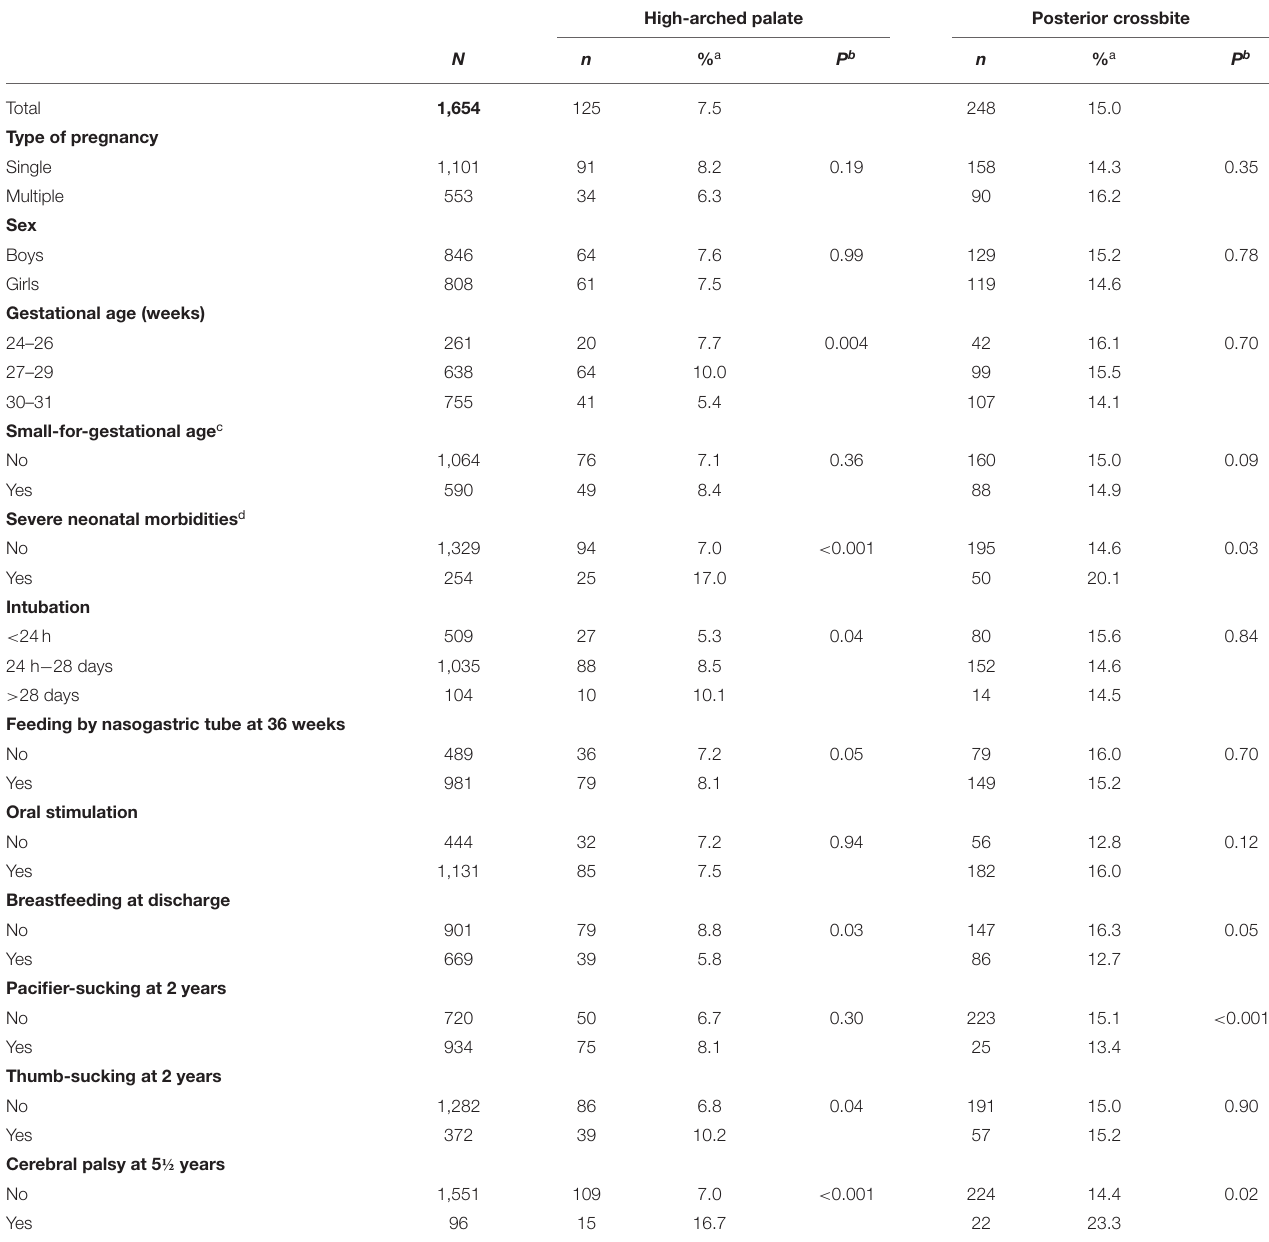
TABLE 2 | Frequency of high-arched palate and posterior crossbite at 5 ½ years by neonatal characteristics, non-nutritive sucking habits (NNSHs) at 2 years, and cerebral palsy at 5 ½ years: complete cases ( n = 1,654). High-arched palate Posterior